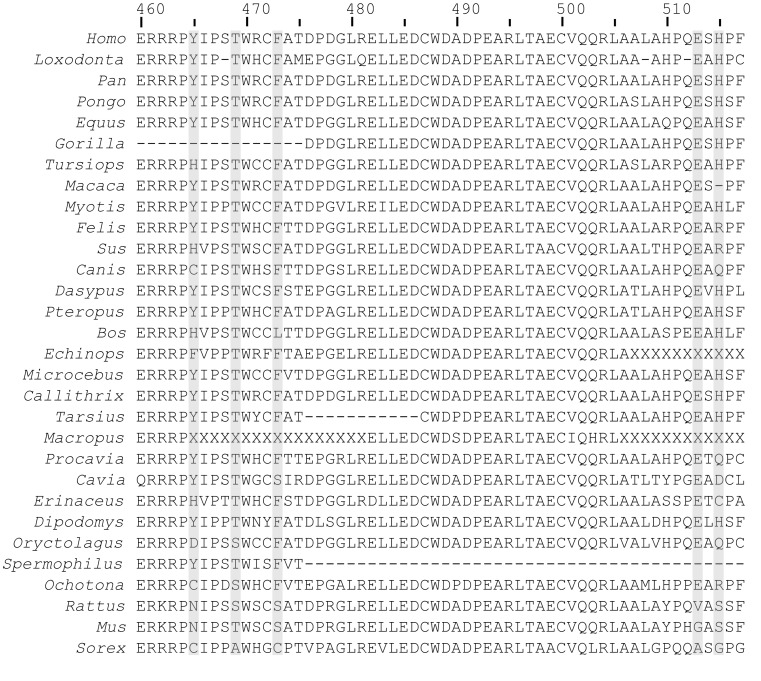
OrthoMaM alignment of the C-terminal regions of AMHR2 ortholog kinase domains.Orthologs are ordered by species MLS. The five longevity-selected positions in this region (Y465, T469, F473, E513, and H515) are highlighted in gray. ";X"; indicates regions that we masked due to excessive divergence (Section 2.1). Long regions of gaps are not necessarily real genome deletions, but are more likely to have been missed during genome assembly or annotation.